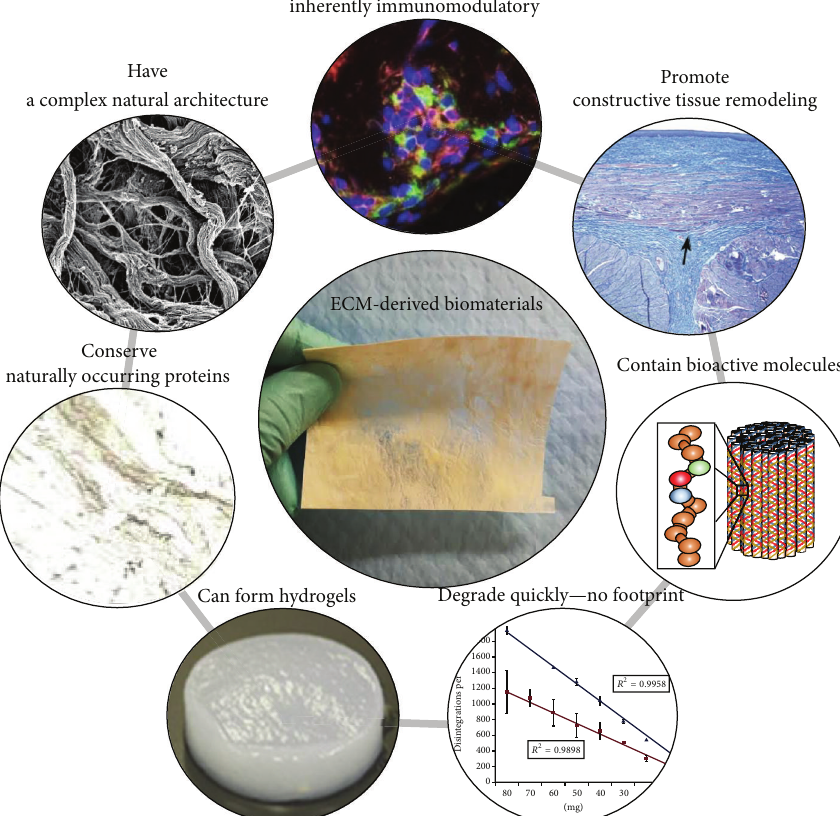
Figure 3: Extracellular matrix-derived biomaterials: Materials derived from the ECM via decellularization of native tissues possess a number of beneficial properties that together promote constructive tissue remodeling. ECM-derived biomaterials can modulate wound healing mechanisms including angiogenesis and the immune system and facilitate important cellular processes such as cell migration, proliferation, and